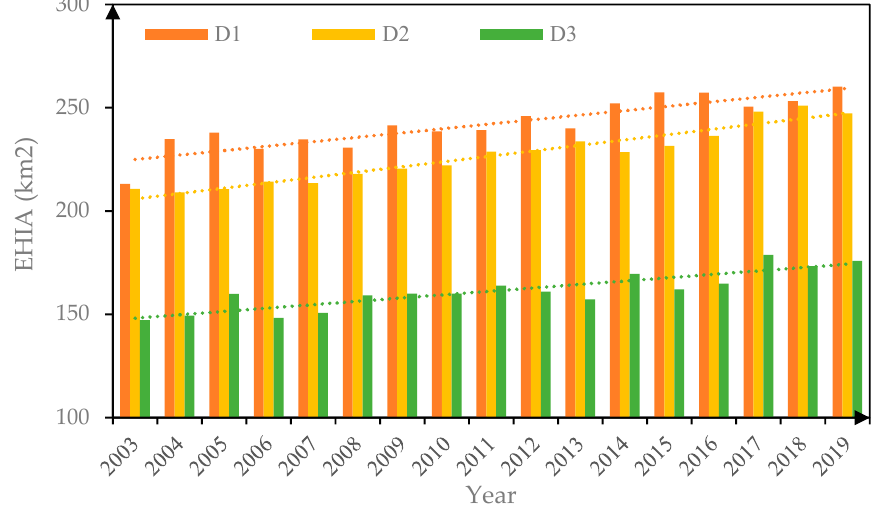
Figure 7. Equivalent heat island area (EHIA) from 2003 to